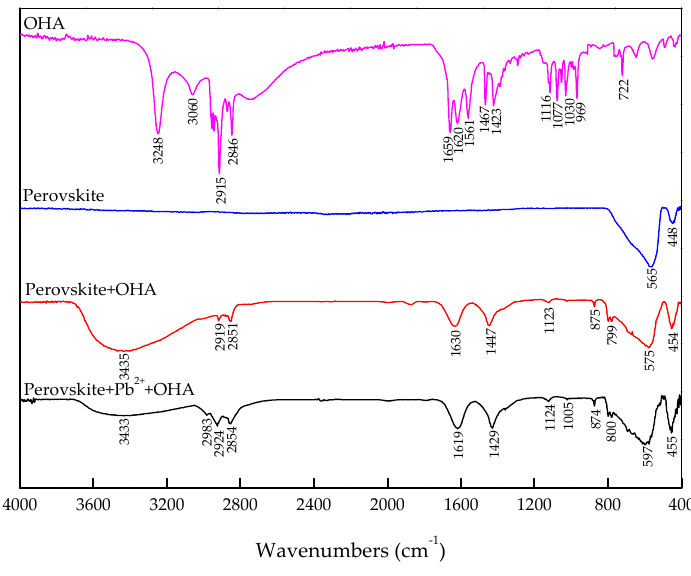
Figure 8. FT ‐ IR spectra of perovskites before and after adjustment with different agents. Figure 8. FT-IR spectra of perovskites before and after adjustment with different